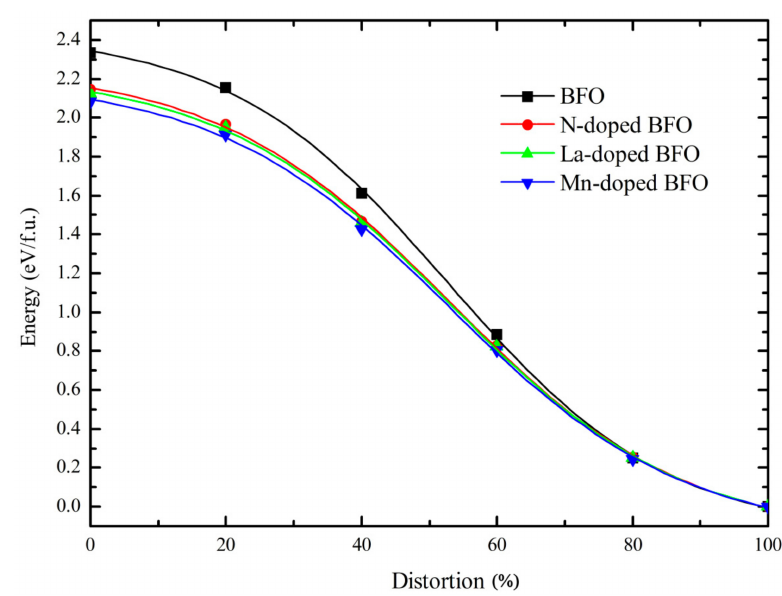
Figure 4. The total energy as a function of percentage of distortion from the centrosymmetric structure to + P 4 mm structure for pure and doping tetragonal BFO.